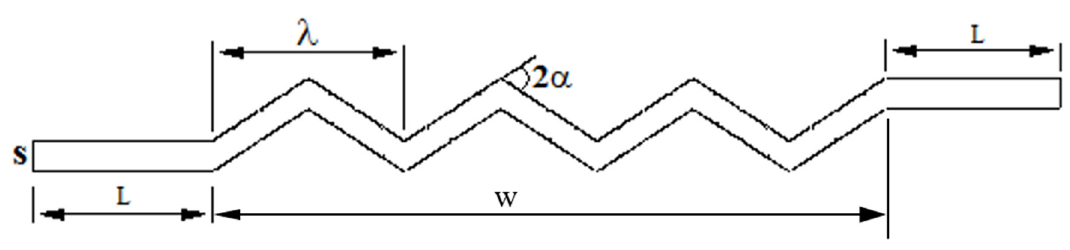
Figure 1. The geometry of the corrugated phase-change material (PCM)–air heat exchanger (one PCM domain).